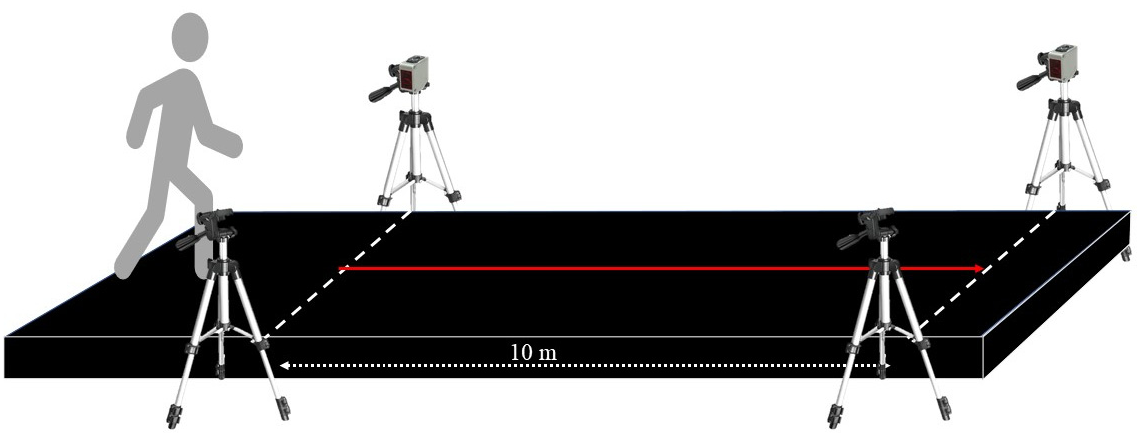
Figure 2. Gait test on walkway delimited by photo cellules.